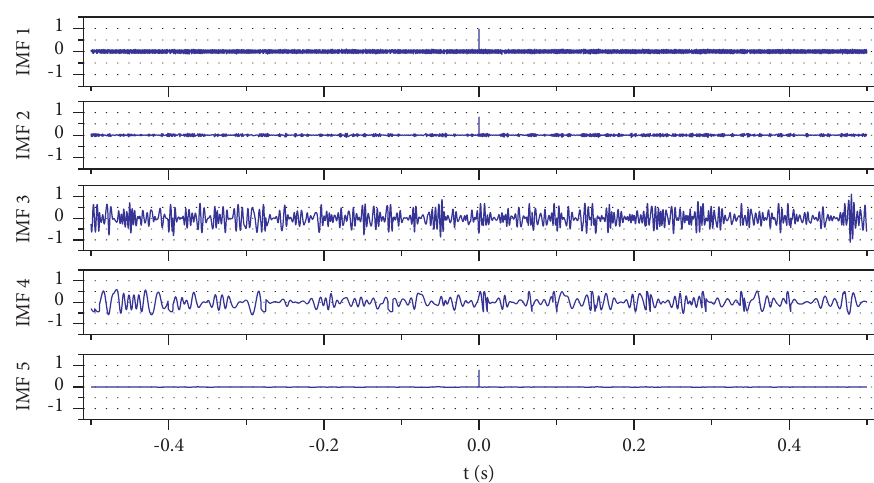
Figure 8: ACF of each IMF by EMD.